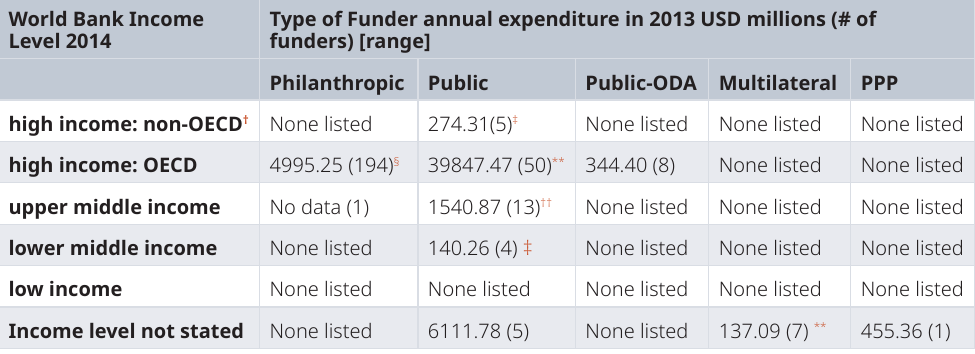
Table 1. Annual Expenditure across health research funders (in 2013 USD millions) by World Bank income level and type of funder.